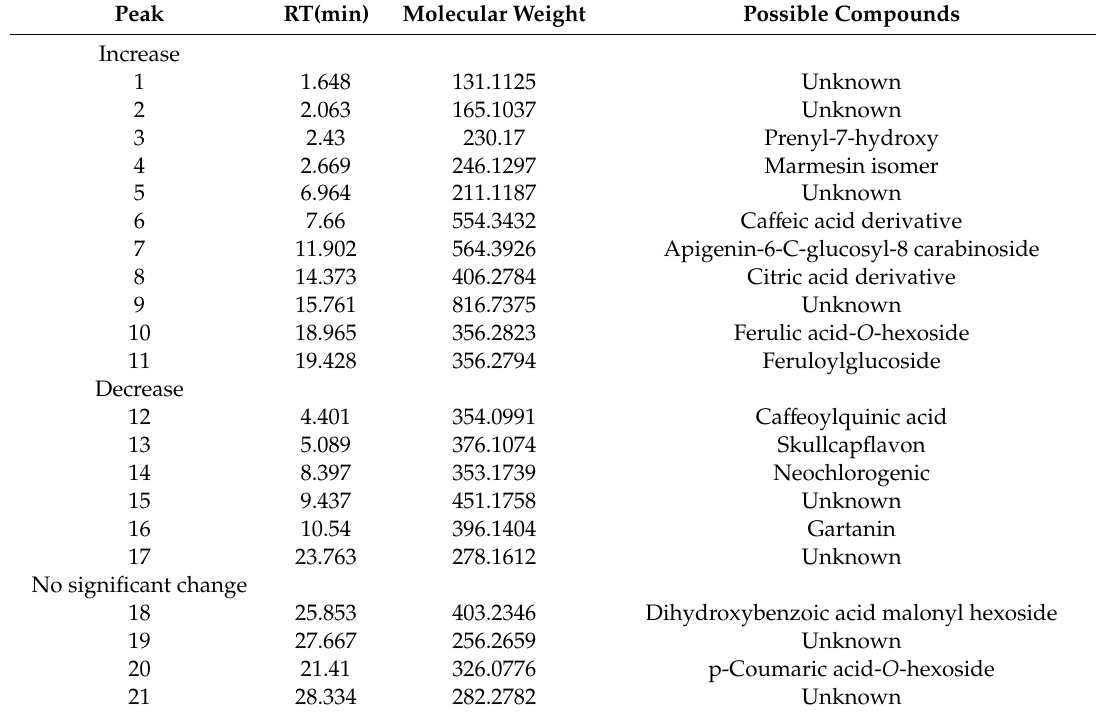
Table 2. Identification of indicated phenolic components from Jackfruit